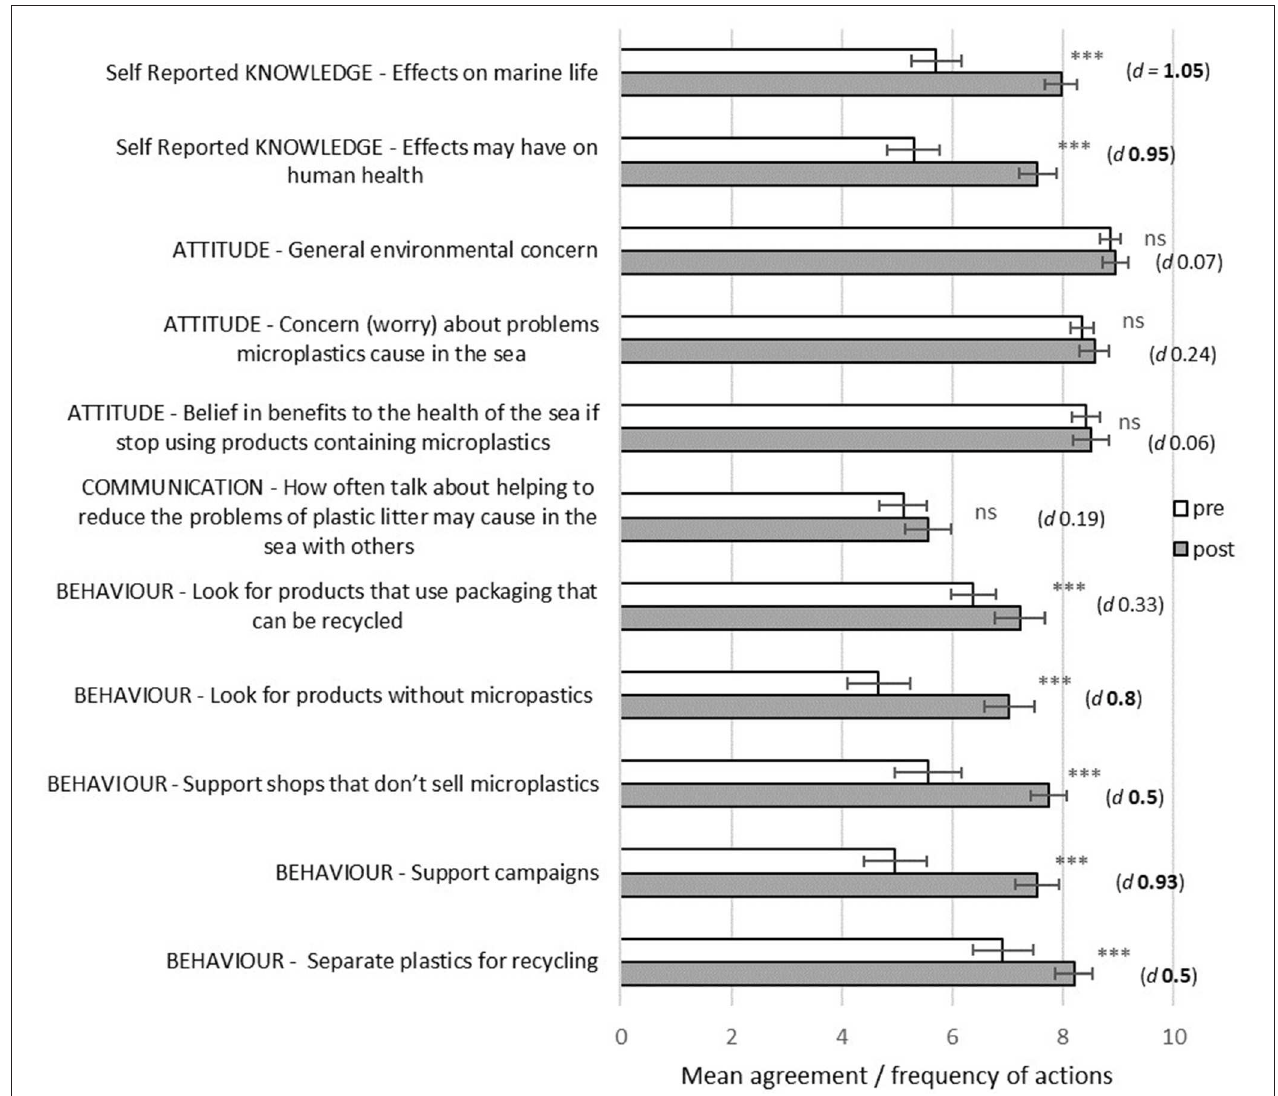
FIGURE 2 | Mean participant responses to pre and post surveys completed before and after viewing the “Rethinking plastic” film, significant differences ( p ≤ 0.005) between pre and post surveys are indicated by ***, effect size (Cohen’s d) of medium or above are in bold ( d = #